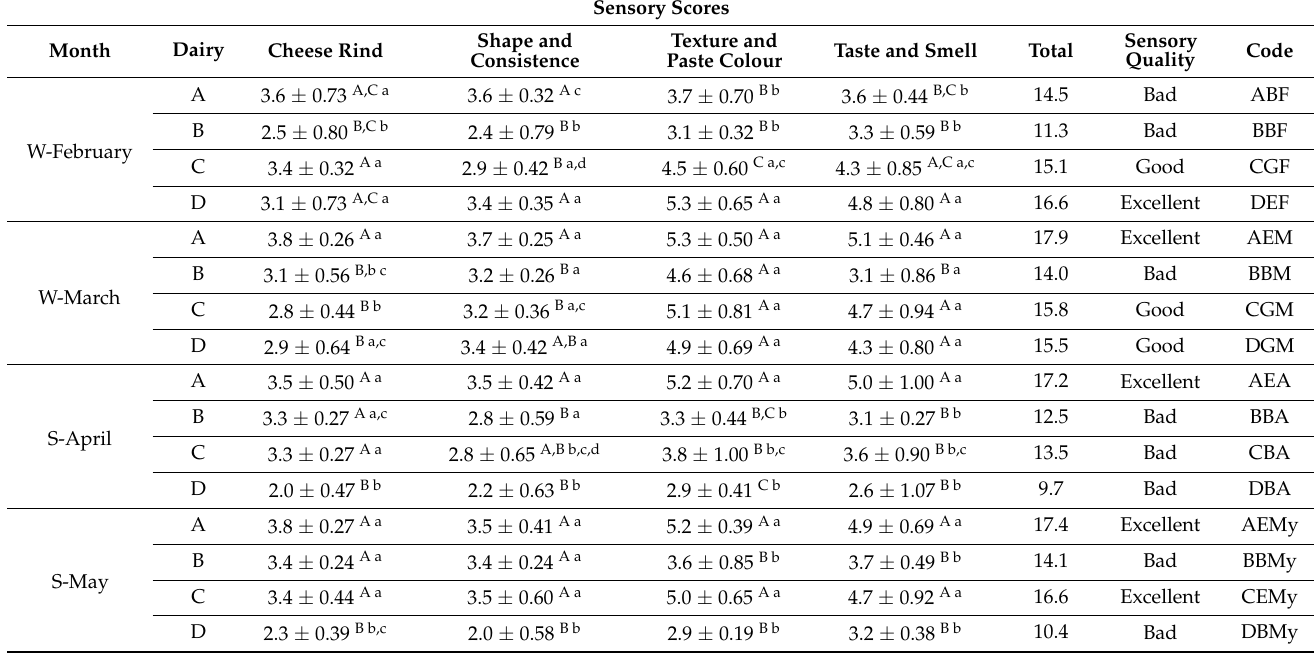
Table 2. Summary of samples analysed and sensory analysis (mean ± standard deviation). Sensory